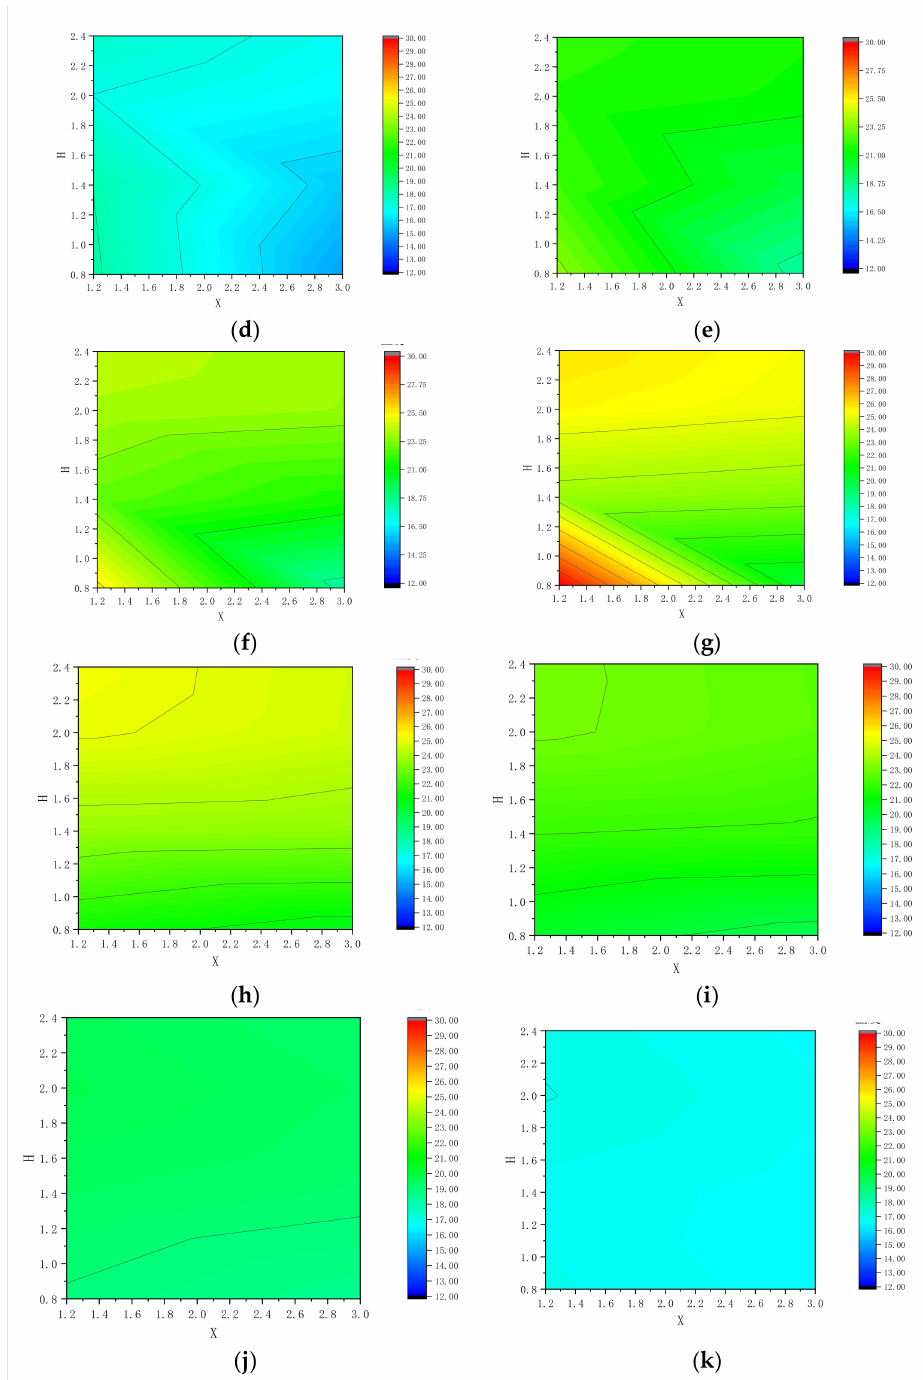
Figure 13. Tangential distribution map of indoor daytime temperature gradient on 28 January; ( a ) Indoor tangential section of temperature field; ( b ) Distribution of temperature field at 9:00; ( c ) Dis- tribution of temperature field at 10:00; ( d ) Distribution of temperature field at 11:00; ( e ) Distribution of temperature field at 12:00; ( f ) Distribution of temperature field at 13:00. ( g ) Distribution of temper- ature field at 14:00; ( h ) Distribution of temperature field at 15:00. ( i ) Distribution of temperature field at 16:00; ( j ) Distribution of temperature field at 17:00; ( k ) Distribution of a temperature field at